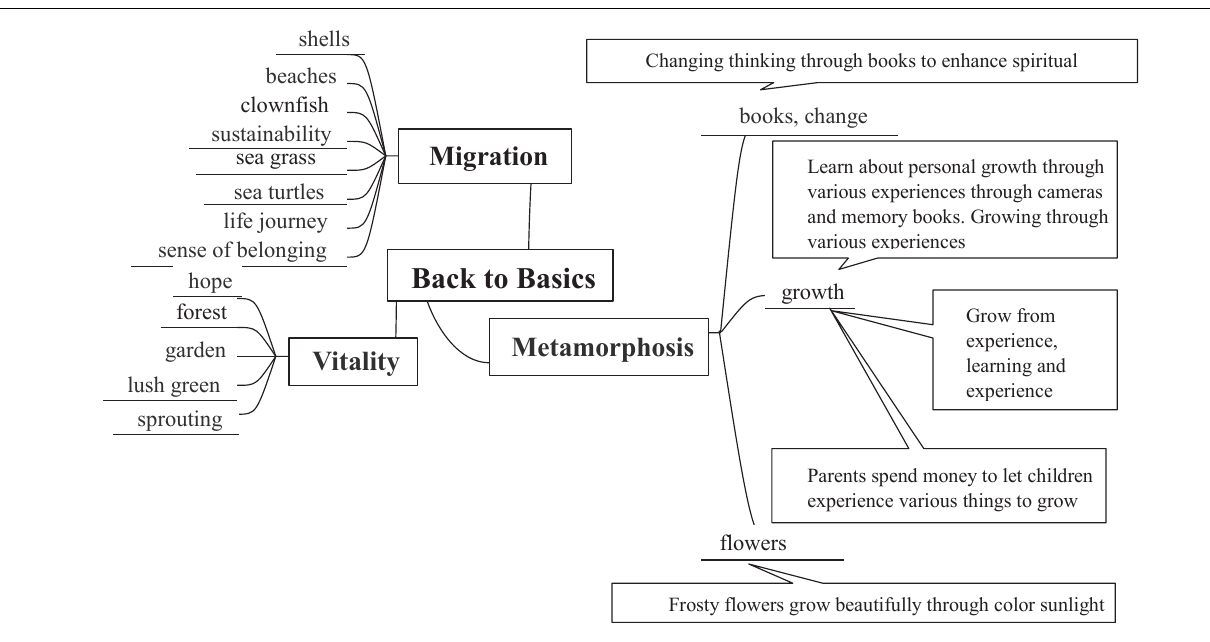
FIGURE 5 | A mind map for the development